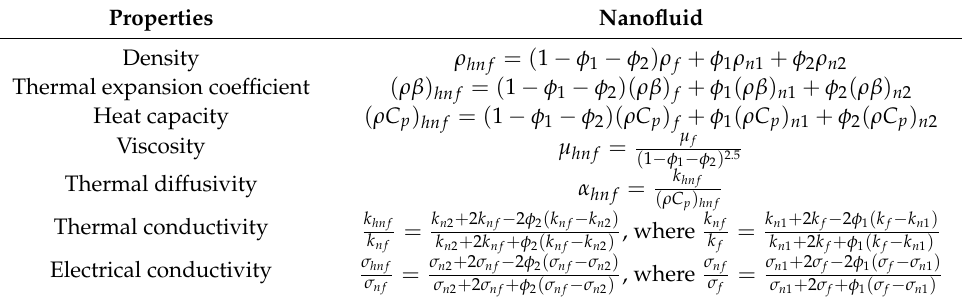
Table 4. Thermophysical properties of hybrid nanofluid (type III)